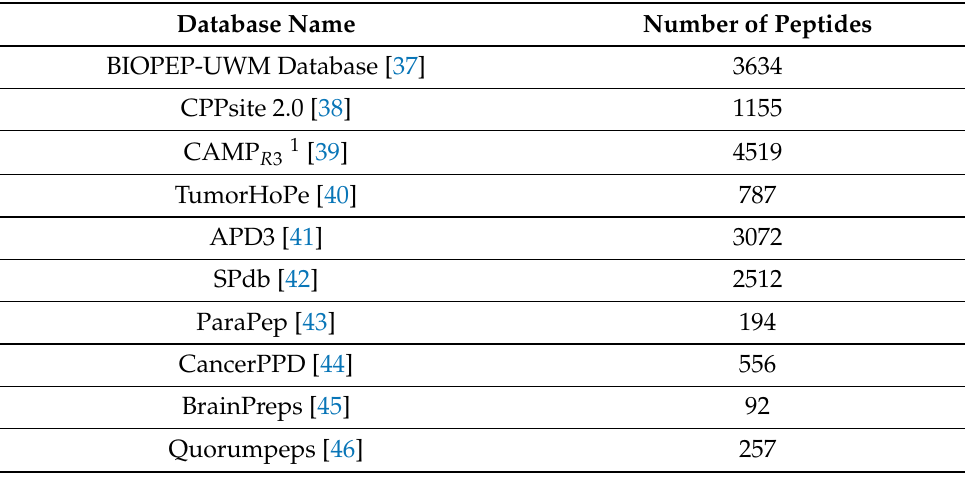
Table 1. Databases recollected to perform the IA model’s training. 1 The database consists of 8305 sequences; however, some are proteins, which are not of interest for this